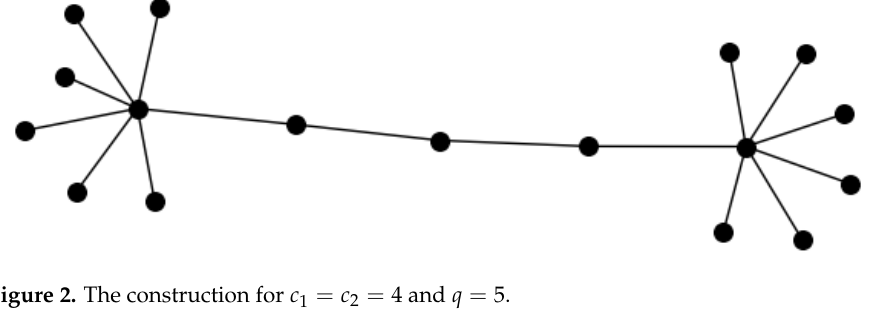
Figure 2. The construction for c 1 = c 2 = 4 and q =